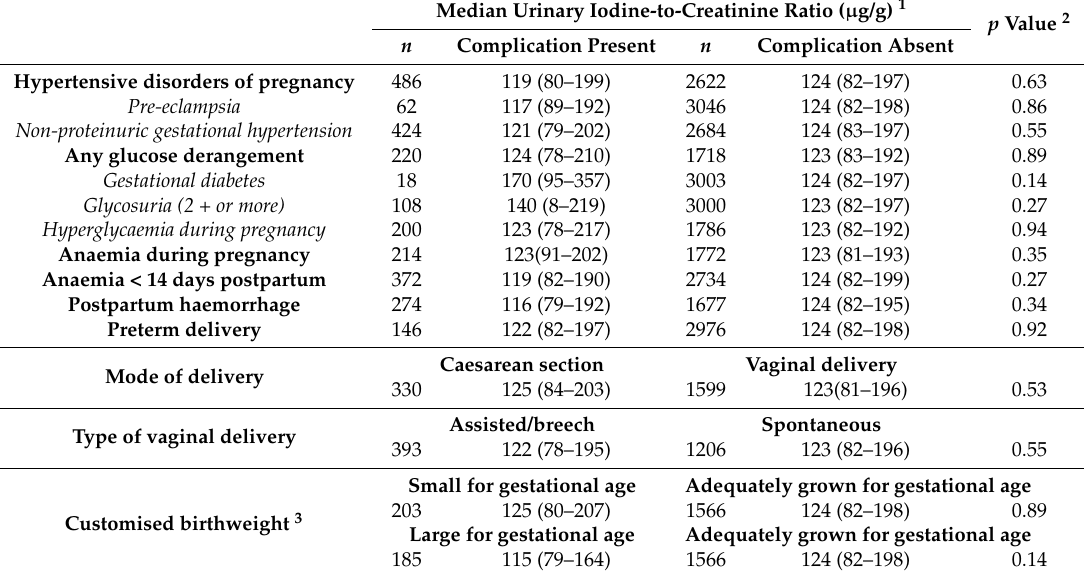
Table 4. Comparison of urinary iodine-to-creatinine ratio (UI/Creat; µ g/g) in those where pregnancy complications were either present or absent. Data based on 3140 pregnant women with infants alive at one